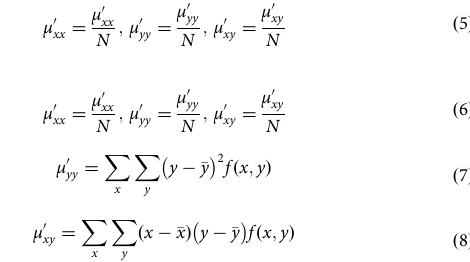
position, while each column represents the spatial signal changes along the intes- tine at a certain time spot. In this spatial-temporal map, the contractions are shown